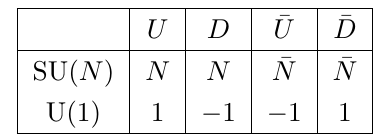
Table 1 . The matter content of a model of the NGAD